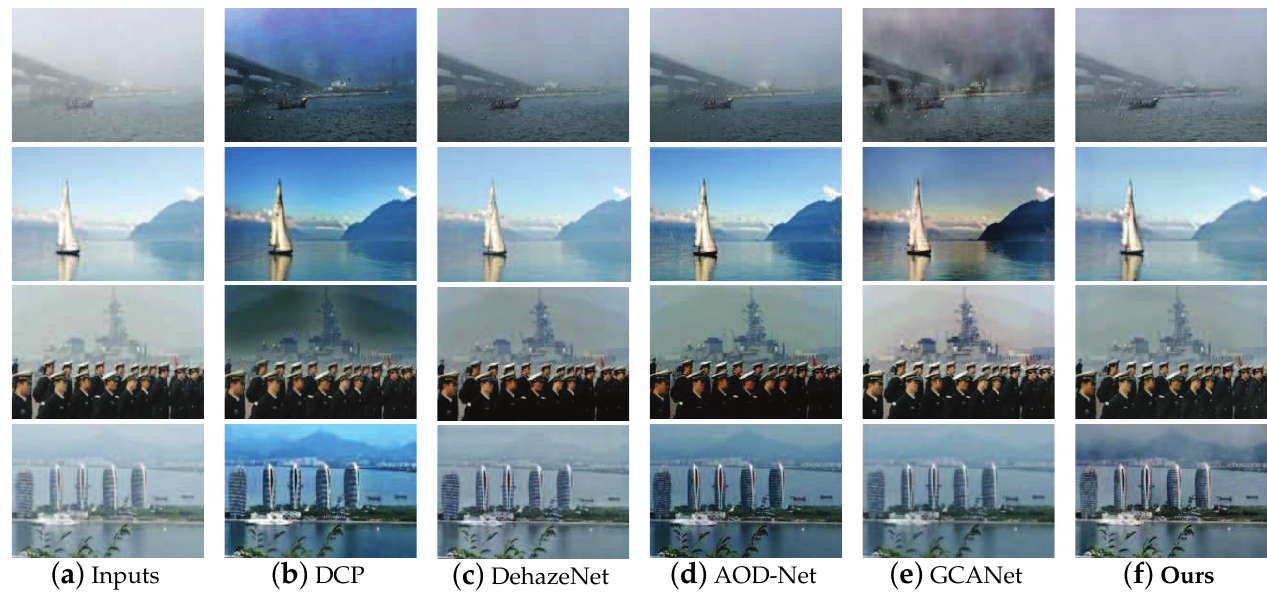
Figure 8. Qualitative comparison of different networks on real-world images. Fig. 8. Qualitative comparison of different networks on real-world images. Table 4. Ablation analysis for each component with different training configurations.